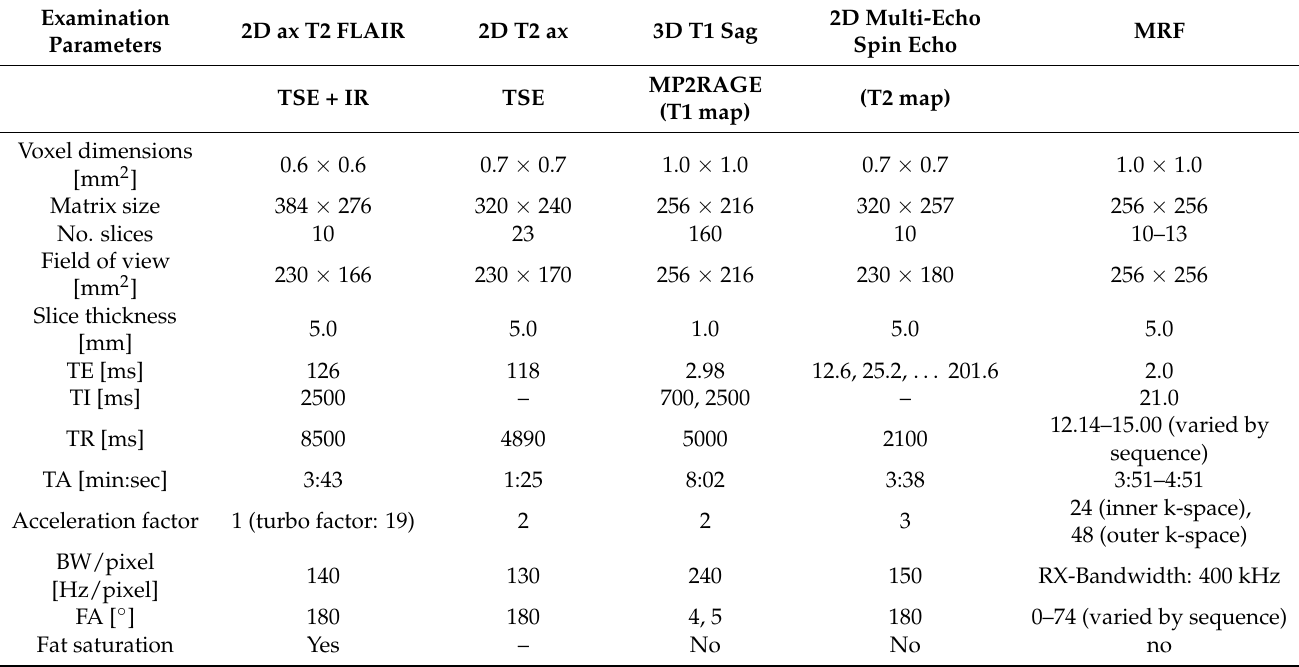
Table 3. MRF protocols used for